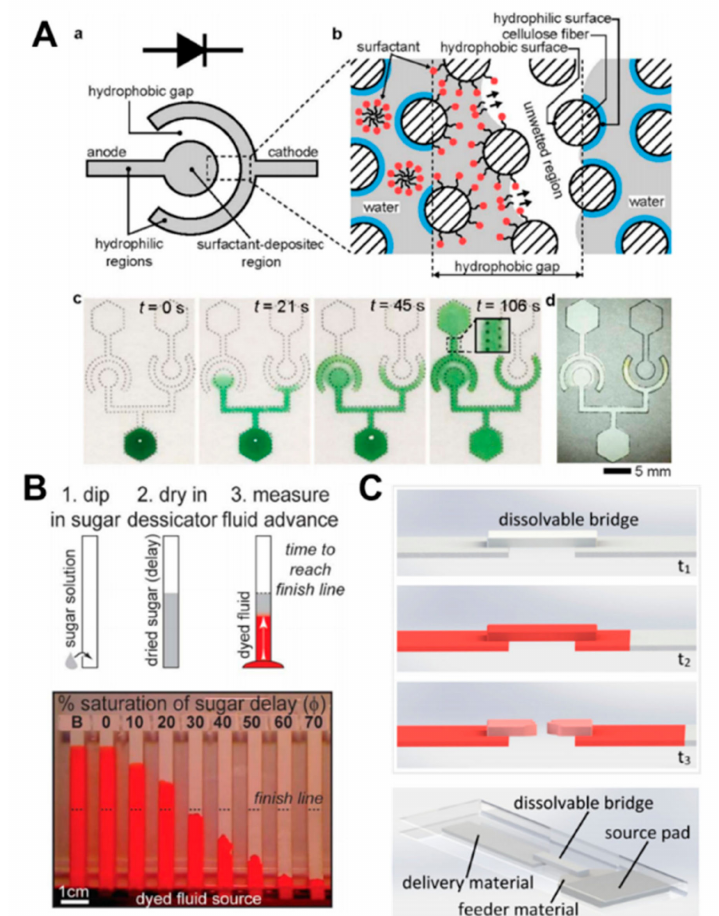
Figure 5. Flow control using chemical-based methods. ( A ) Schematic of a one-directional fluidic diode and illustration of the working mechanism of the fluidic diode. Fluid flows through the hydrophobic gap from the surfactant side. The images show that the green-dyed fluid flows through the diodes (reproduced from ref [121] with permission from the Royal Society of Chemistry, 2012). ( B ) Preparation steps of delayed strip using sugar solution. Experimental images show the flow test with varying concentrations of sugar solution, and the dashed line and strip “B” indicate the finish line and an untreated strip, respectively (reproduced from ref [122] with permission from the Royal Society of Chemistry, 2013). ( C ) Schematic of operation mechanism and set-up of a dissolvable bridge. The bridge dissolves at a certain time to shut-o ff the fluid flow (reprinted with permission form ref [124]. Copyright 2013 American Chemical